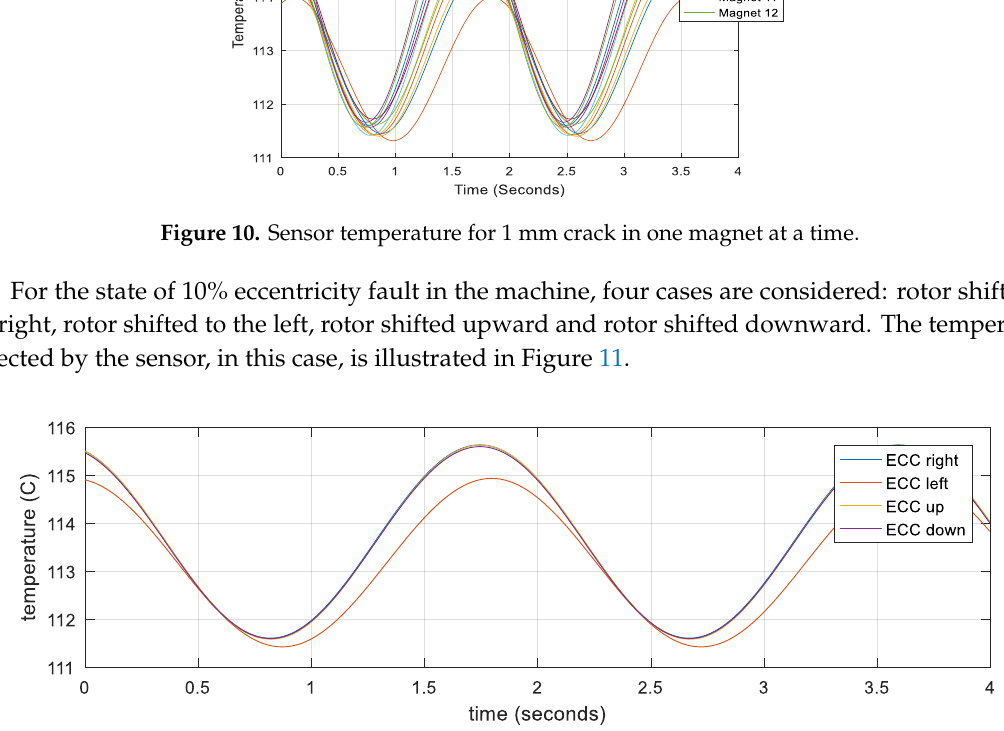
Figure 11. Sensor temperature for machine with 10% eccentricity faults.